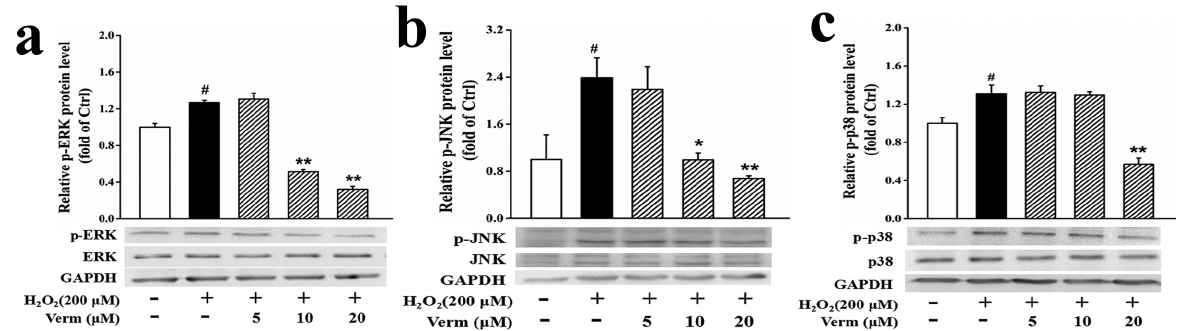
O -induced HDF. The phosphorylation levels of eRK ( a ), JNK 2 2